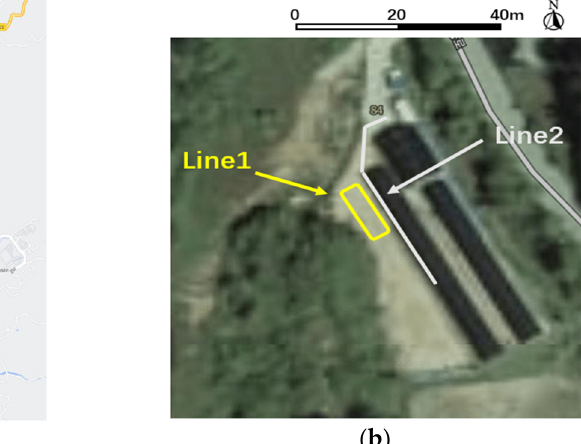
Table 3. Specifications of iAHRS-RB-SDA-v1. Parameter